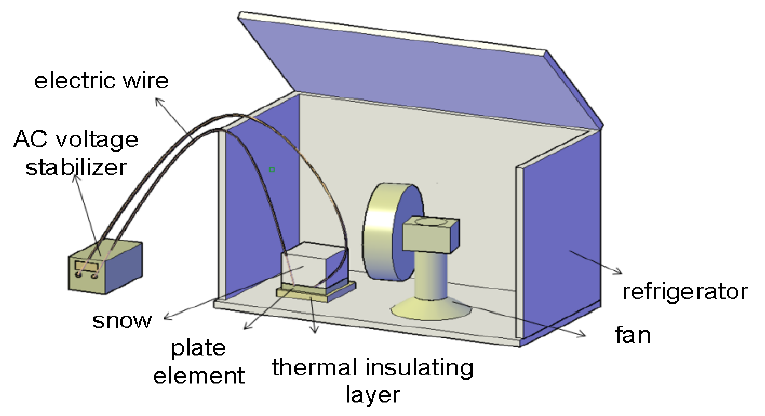
Figure 2. Operational picture of snowmelt test.